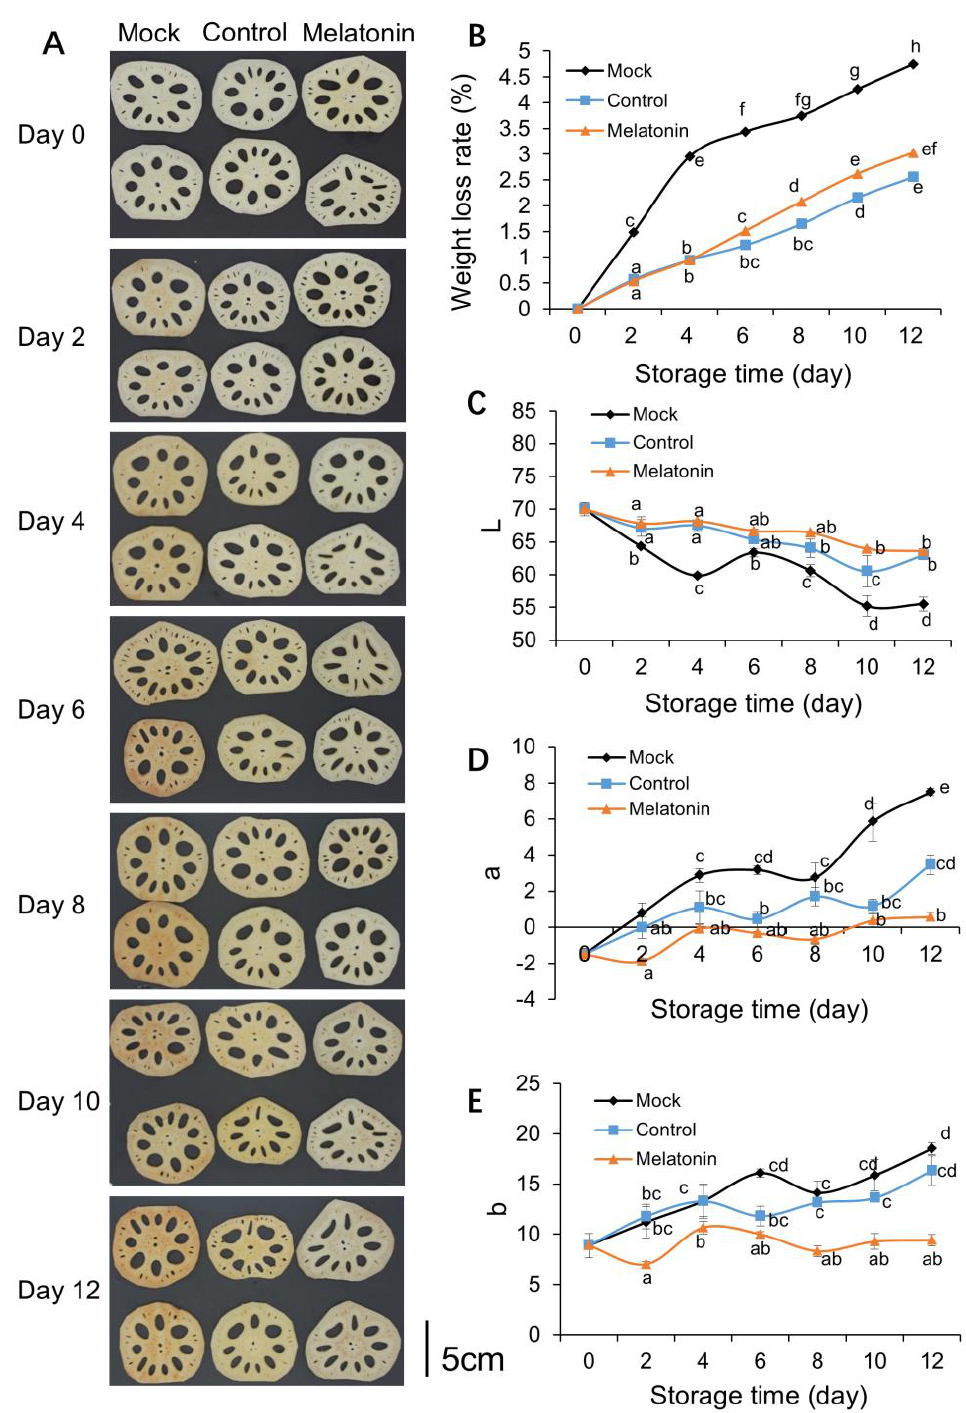
Figure 1. Effect of melatonin on the appearance, water loss, and color ( A – E ) of fresh-cut lotus roots (‘E Lian 5’). Fresh-cut lotus roots were treated with tap water (control, left triangle) or 40 mmol/L melatonin solution (melatonin, circles). Error bars represent SEs from three biological replicates. Different letters represent significant differences at p < 0.05 level.